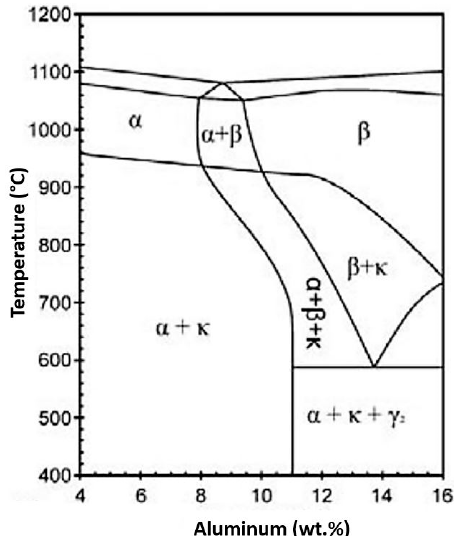
Figure 1. Phase diagram of the Cu-Al system with addition of 5 wt% nickel and 5 wt% iron [12].